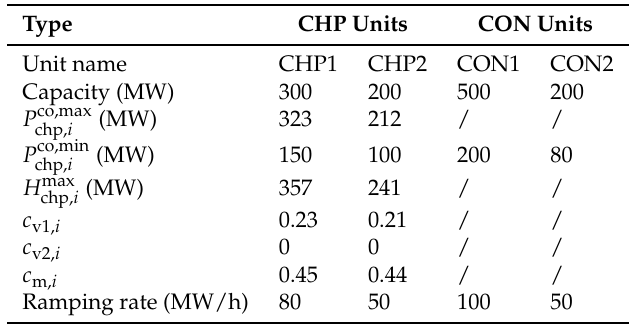
Table 1. Parameters of thermal power units.